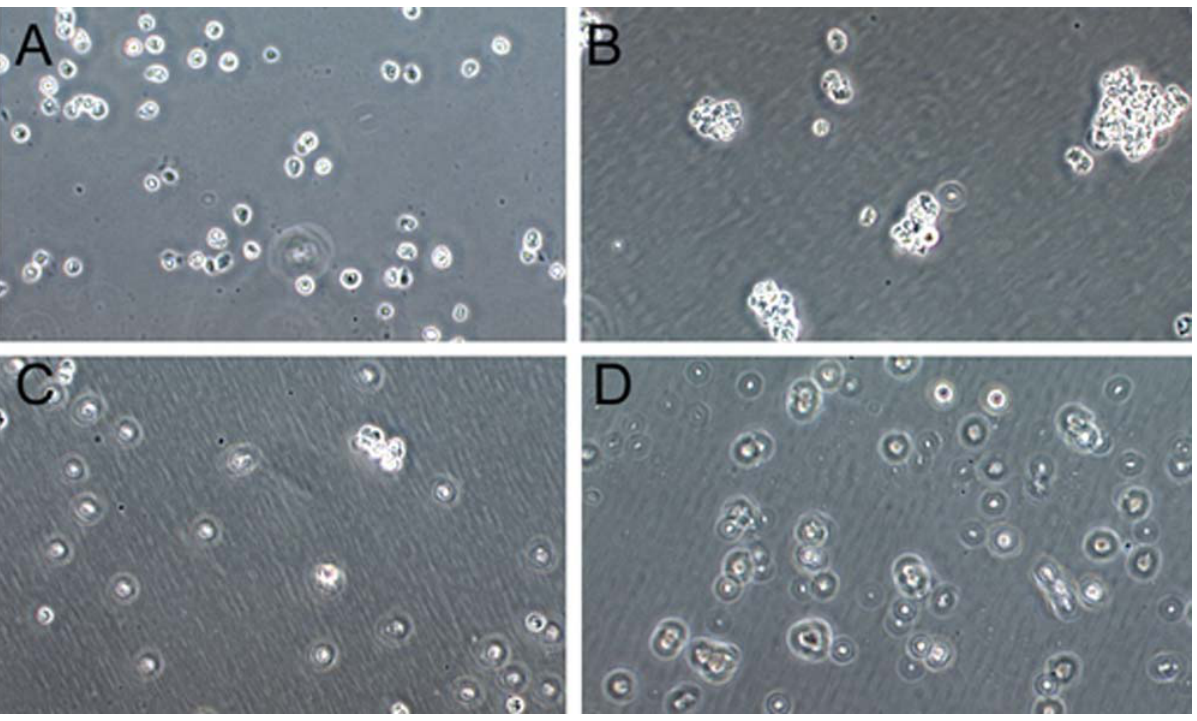
Figure 3. L-cell aggregation assay. Aggregation assays with various cell lines were performed using a standard hanging-drop method. A, Parental L-cells. B, L-cells transfected with WT Bves, C, KK-Mut Bves and D, KK-Del Bves. (Scale Bar 50 m m)